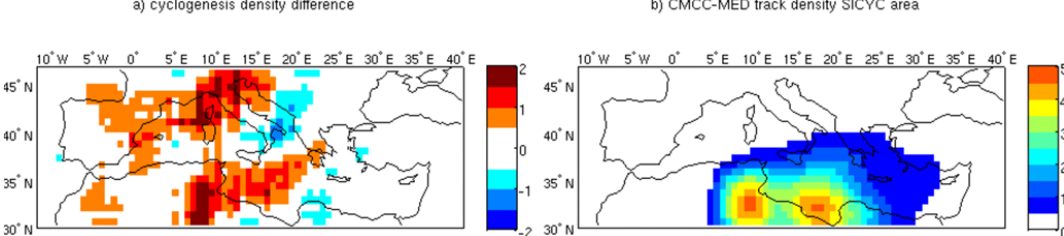
Fig. 5. Panel (a) : annual differences (CMCC-MED-CMCC-CM) in cyclogenetic regions associated to precipitation over SIPREC area (de- fined in the text and shown in Fig. 4a). Panel (b) : annual mean track density of cyclones originating from SICYC area (defined in the text) in CMCC-MED climatology. Only densities greater than .5yr − 1 (lower than -.5yr − 1 ) are shaded. Isolines according to colorbars.